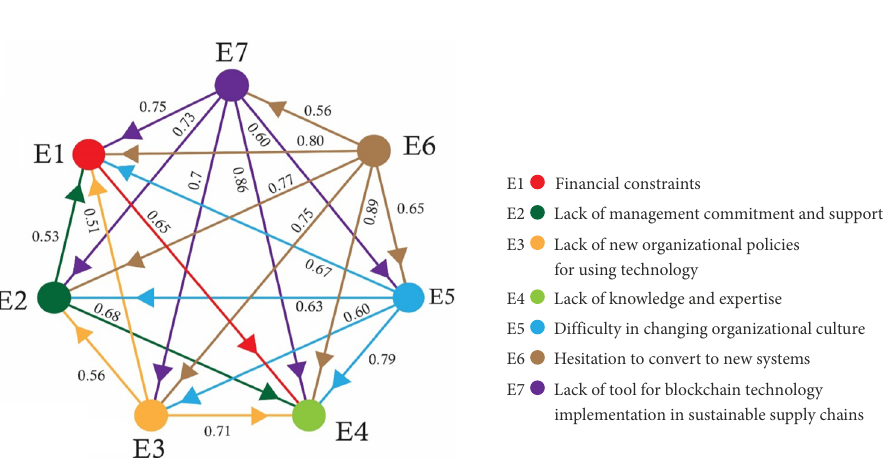
Figure 7. The visualization of the credal ranking for system related barriers